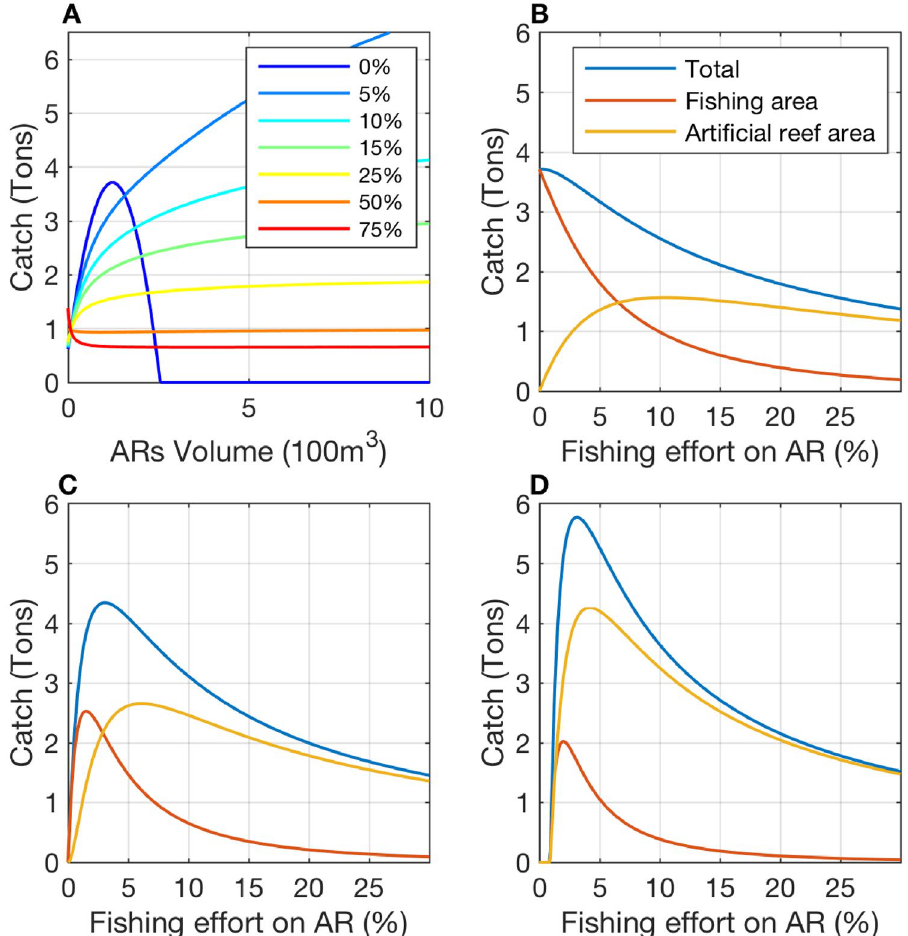
Figure 2. Mathematical model predictions of the catch resulting from interaction between the volume of artificial reef (AR) and fishing effort. ( A ) Colored curves correspond to different levels of (illegal) fishing effort across the ARs; the gradient from dark blue to orange represents 0, 5, 10, 15, 25, 50 and 75% of the total fishing effort. ( B – D ) Blue, red, and yellow curves correspond to total catch, catch in the fishing area, and catch on the AR, respectively, which is 120, 200 and 500 m 3 respectively in subfigures B and C. Note, for zero (0%) illegal fishing, there is an optimal volume of AR ( A ); below this optimal volume, increasing illegal fishing decreases catch ( B ); in contrast, for higher AR volume, there is an optimal level of illegal fishing ( C ). The artificial reefs used in the model have production (δk = 5) and attraction (β 0 = 1) effects (see complete analysis of the mathematical model in the supplementary text). Sensitivity tests with different artificial reef production and attraction levels are presented in Fig.